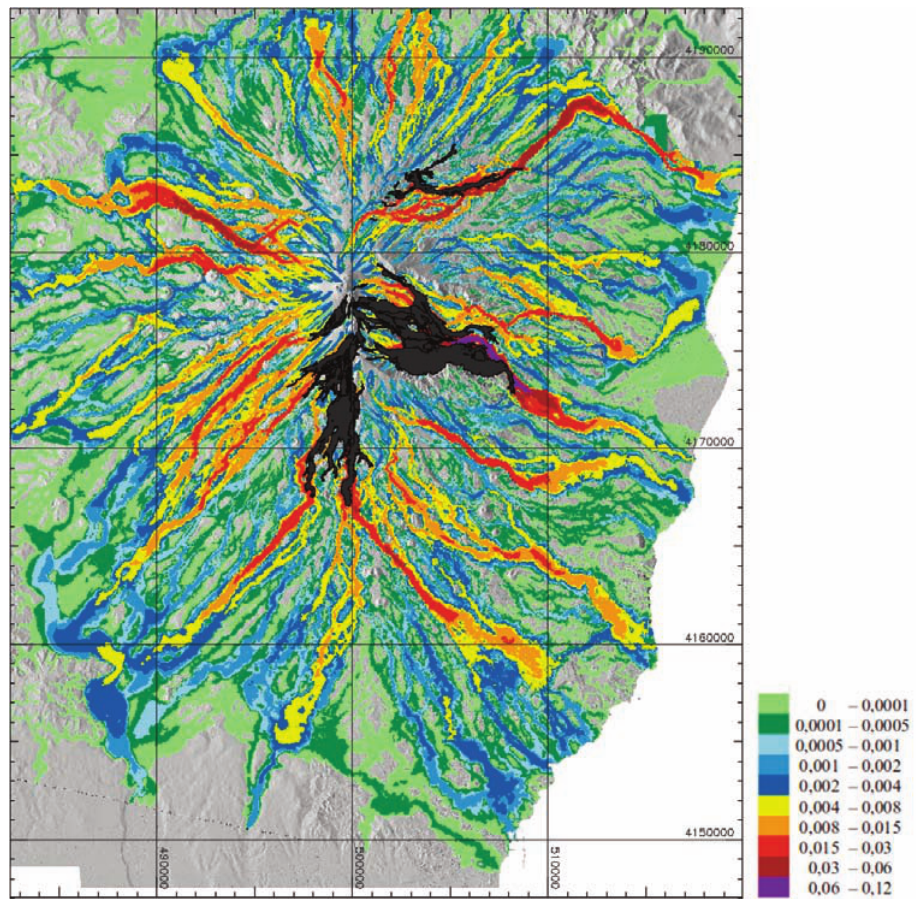
Figure 3. Lava-flow hazard map for Mount Etna constructed using the learning dataset (reference time 1981) with superimposed actual lava-flow paths from eruptions that occurred after 1981 (in black). The colors represent different levels of lava-flow invasion